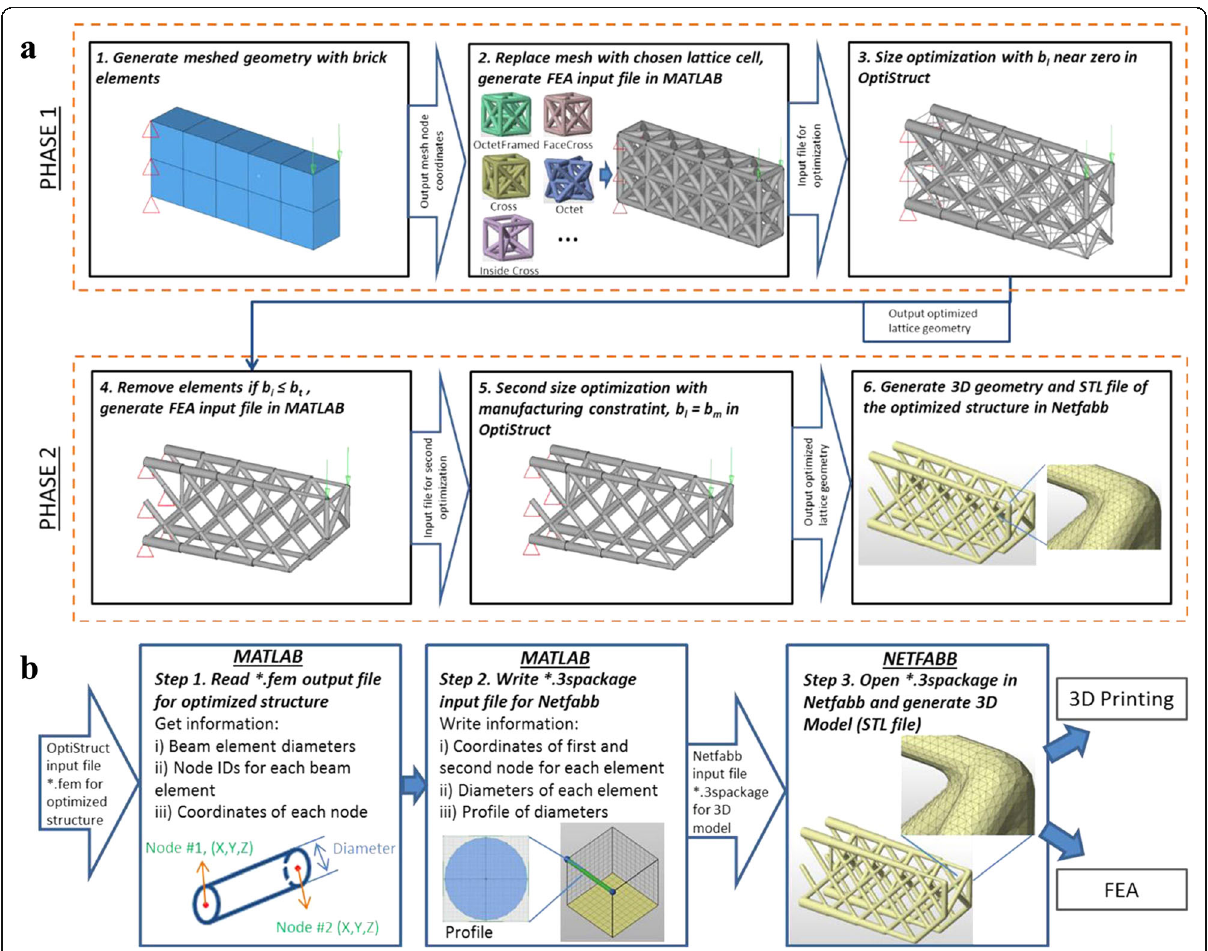
Fig. 22 Optimization design method: a Lattice design process. b Specific steps consist of MATLAB and Netfabb softwares